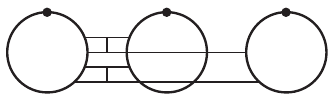
Figure 9.3 . A diagram D with (W s ⊗ W s ) ◦ ∆ ob (D) = 0 and W e (p ∗ (D)) ≠